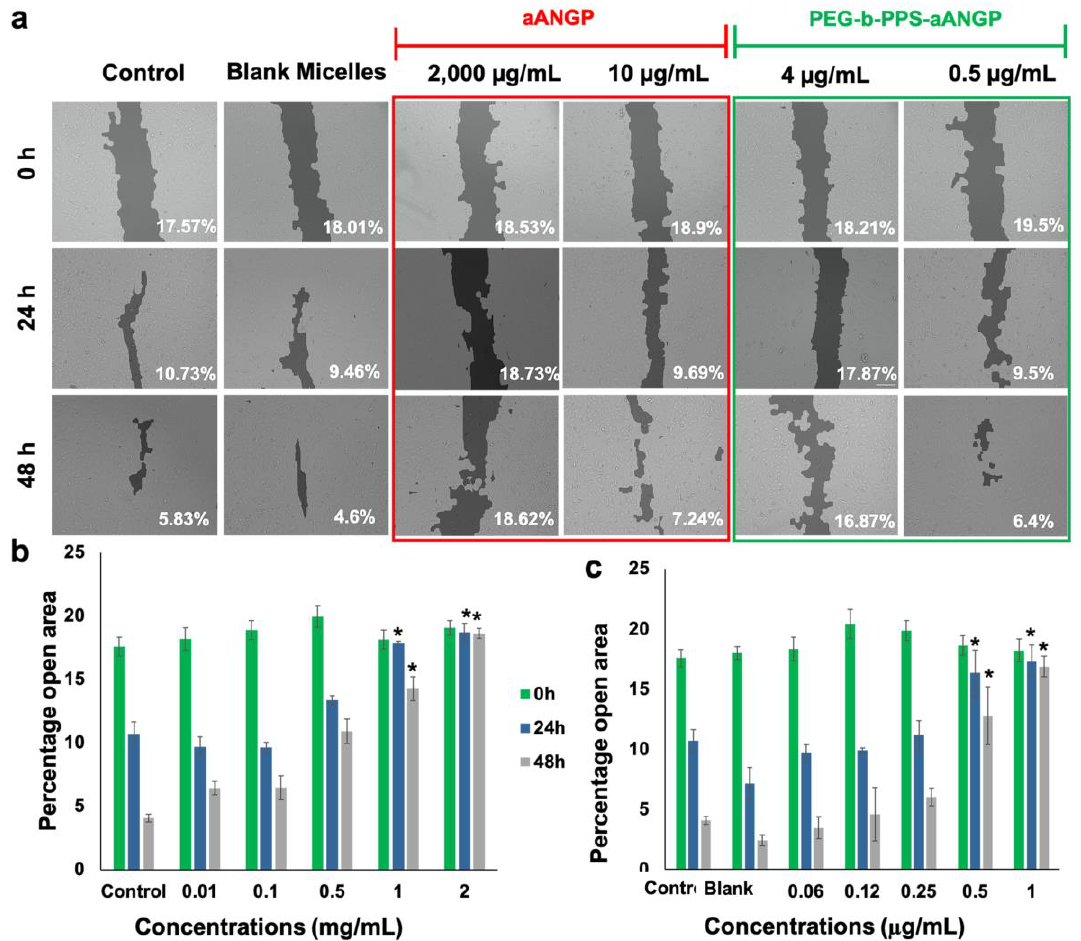
Figure 5. E ff ect of aANGP and aANGP-MCs on the migration of HUVECs. ( a ) HUVECs were treated with di ff erent concentrations of aANGP and aANGP-MCs for 24 and 48 h and imaged at 0, 24, and 48 h using an inverted microscope at 10 × magnification. Bar graphs represent the quantification of the images obtained for ( b ) aANGP and ( c ) aANGP-MCs. Values were expressed as mean SD, n = 3. * p < 0.005.